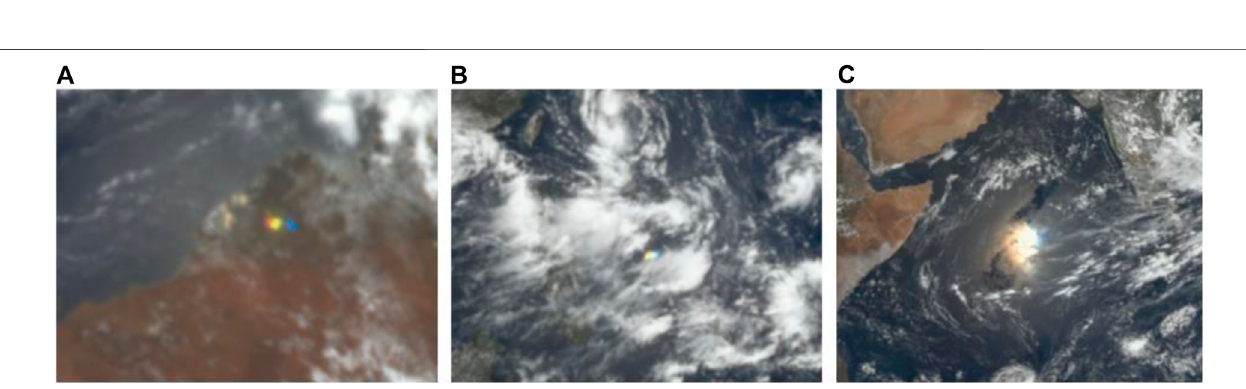
FIGURE 4 | Three examples of glints captured by DSCOVR/EPIC in 2018. The Sun-Earth-Vehicle (SEV) angle is around 9 ° . Note that the fi lter wheel used to select EPIC wavelengths causes a time lag between the component images in these red-green-blue (RGB) composites: ∼ 3 min between blue (443 nm) and green (551 nm); ∼ 4 min between blue and red (680 nm). (A) Terrestrial glint over Australia from cloud ice crystals on February 13, 2018 (see https://epic.gsfc.nasa.gov/?date (cid:2) 2018-02- 13); (B) Terrestrial glint over the Paci fi c Ocean from marine cloud ice crystals on June 15, 2018 (see https://epic.gsfc.nasa.gov/?date (cid:2) 2018-06-15); (C) Ocean surface glint on September 17, 2018 (see https://epic.gsfc.nasa.gov/?date (cid:2) 2018-09-17).